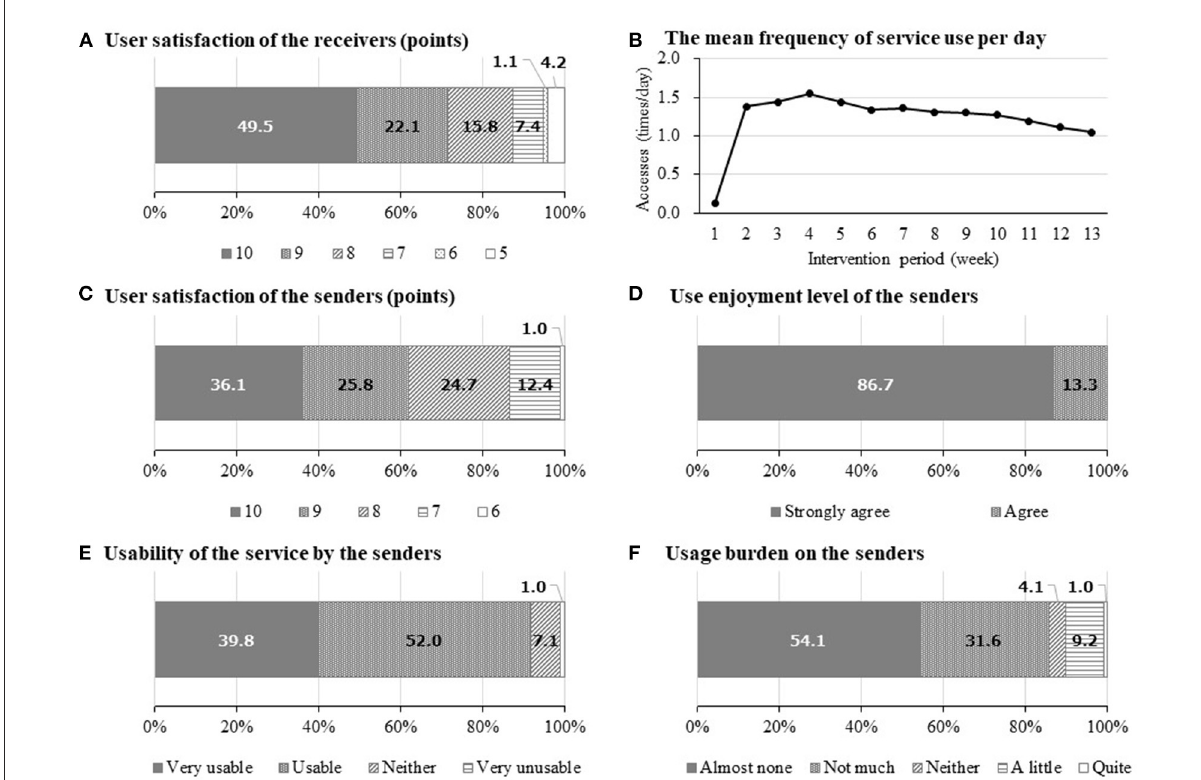
FIGURE2 User satisfaction and status of the service during the intervention period. (A,B) are data from participants (middle-aged and older adults), and (C–F) are data from senders such as separated family members. (A) User satisfaction score (0–10 points) by the receivers: mean score (standard deviation: SD) = 9.0 (1.3). (B) The mean frequency of service use per day (times/day) by participants during the intervention periods ( n = 106). (C) User satisfaction score (0–10 points) by the senders ( n = 97): mean score (SD) = 8.84 (1.09). (D) Use enjoyment level of the senders ( n = 98).